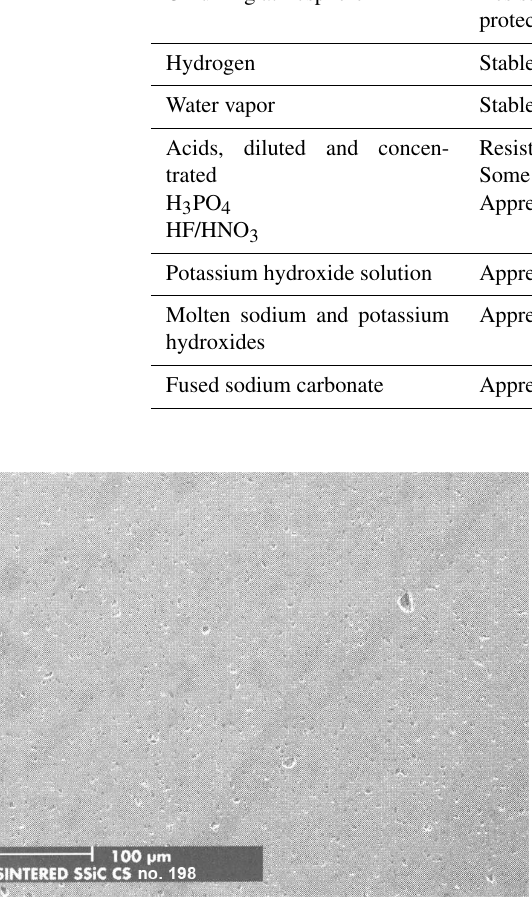
Figure 1. Microstructure of polished cross section of SSiC, SEM.